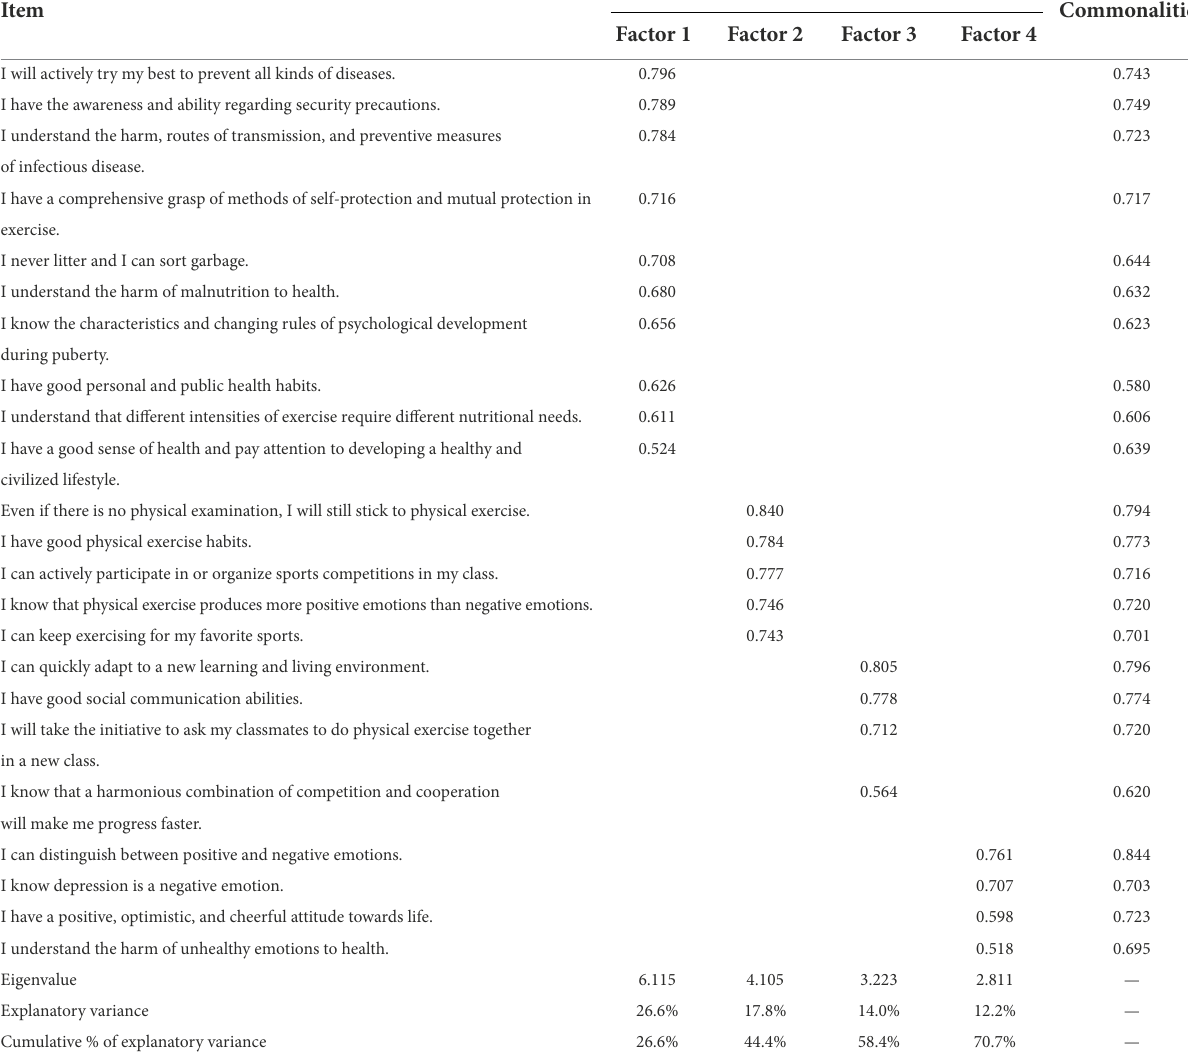
Convergent and discriminant validity root of AVE, which is shown in Table 5.